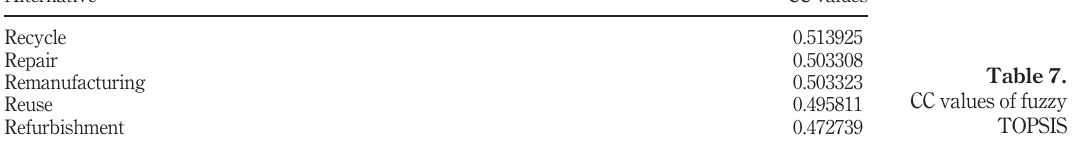
Table 7. CC values of